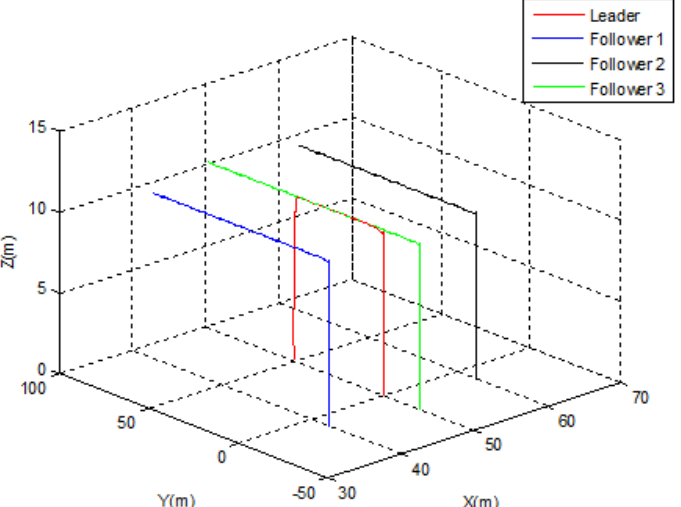
Figure 11. Leader election Case 3.